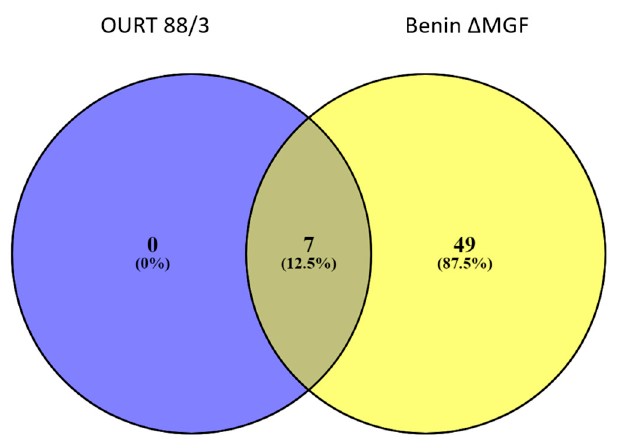
Figure 4. Swine proteins on EV-enriched fractions evaluated at 24 days post infection (red proteins were significant at p < 0.05) and above the volcano plot threshold ( p < 0.01). ( a ) Proteins di ff erentially expressed in EV-enriched fractions from Group A (infected with OURT 88 / 3). ( b ) Proteins di ff erentially expressed in EV-enriched fractions from Group B (infected with Benin ∆ MGF).